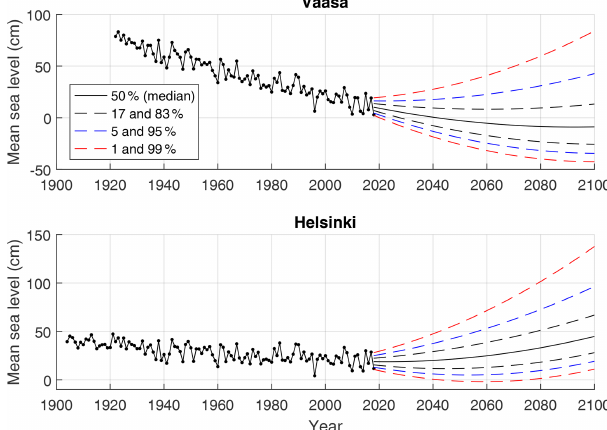
Figure 8. Observed annual mean sea levels and future projections under the medium-emission scenario (RCP4.5/SSP2-4.5) in Vaasa, region of strong land uplift, and Helsinki, where the land uplift is weaker. The reference level is the Finnish N2000 height reference